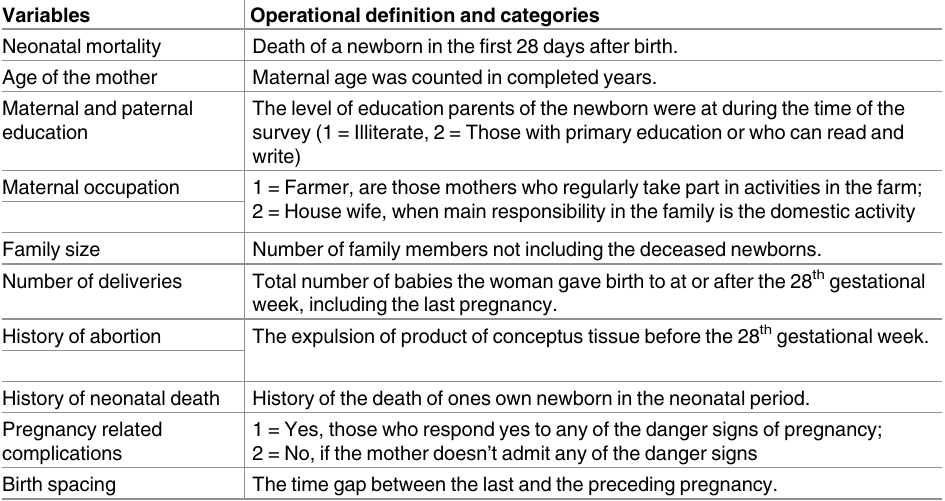
Table 1. Operational definition and categorization of variables used in the analysis West Gojam zone, Feb